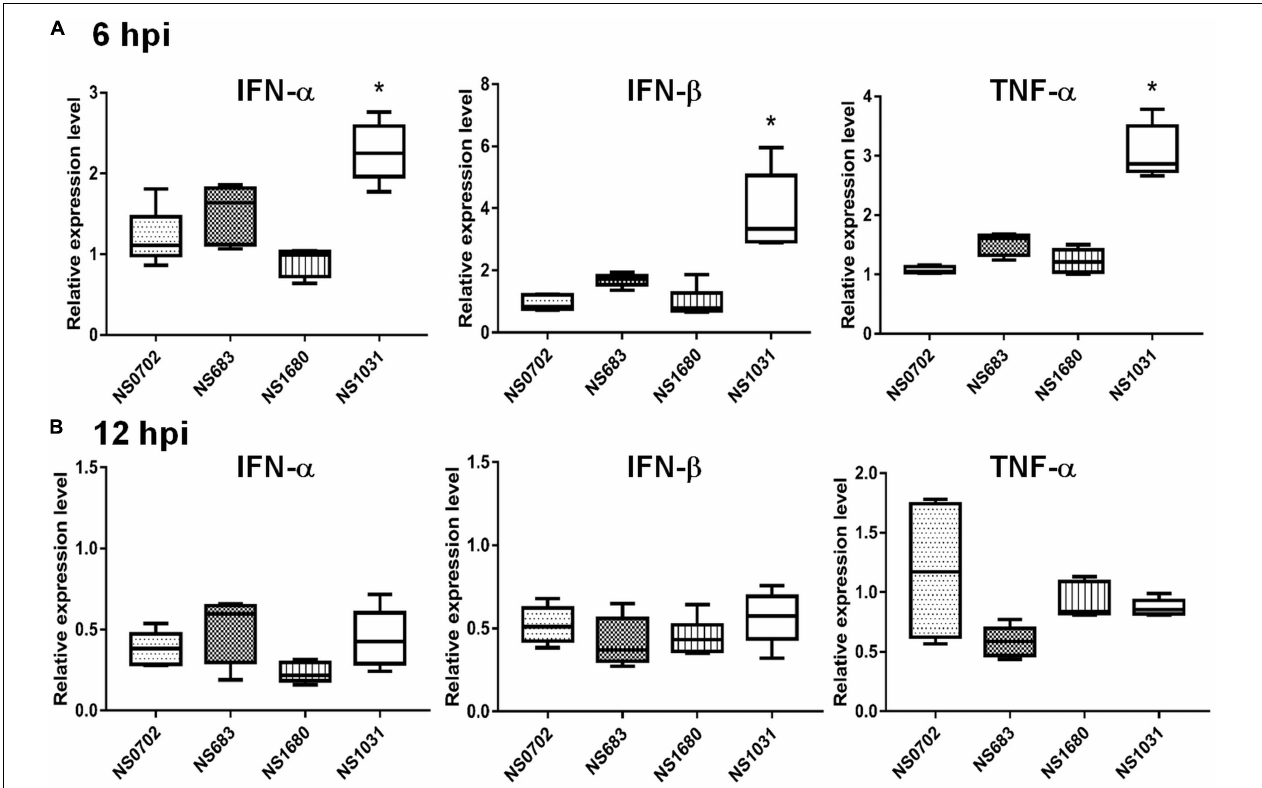
FIGURE 5 | Expression of cytokines in chickens infected with reassortant avian influenza viruses engineered by reverse genetics (RG-AIVs). One-day-old chickens received AIV [5 × 10 5 plaque-forming units (PFU)/chicken] by intratracheal instillation. Total IFN- α , IFN- β , and TNF- α RNA were extracted from the lungs at (A) 6 and (B) 12 hpi for qRT-PCR quantification of cytokines. *Indicates significant difference ( p < 0.05) in cytokine expression relative to parental virus